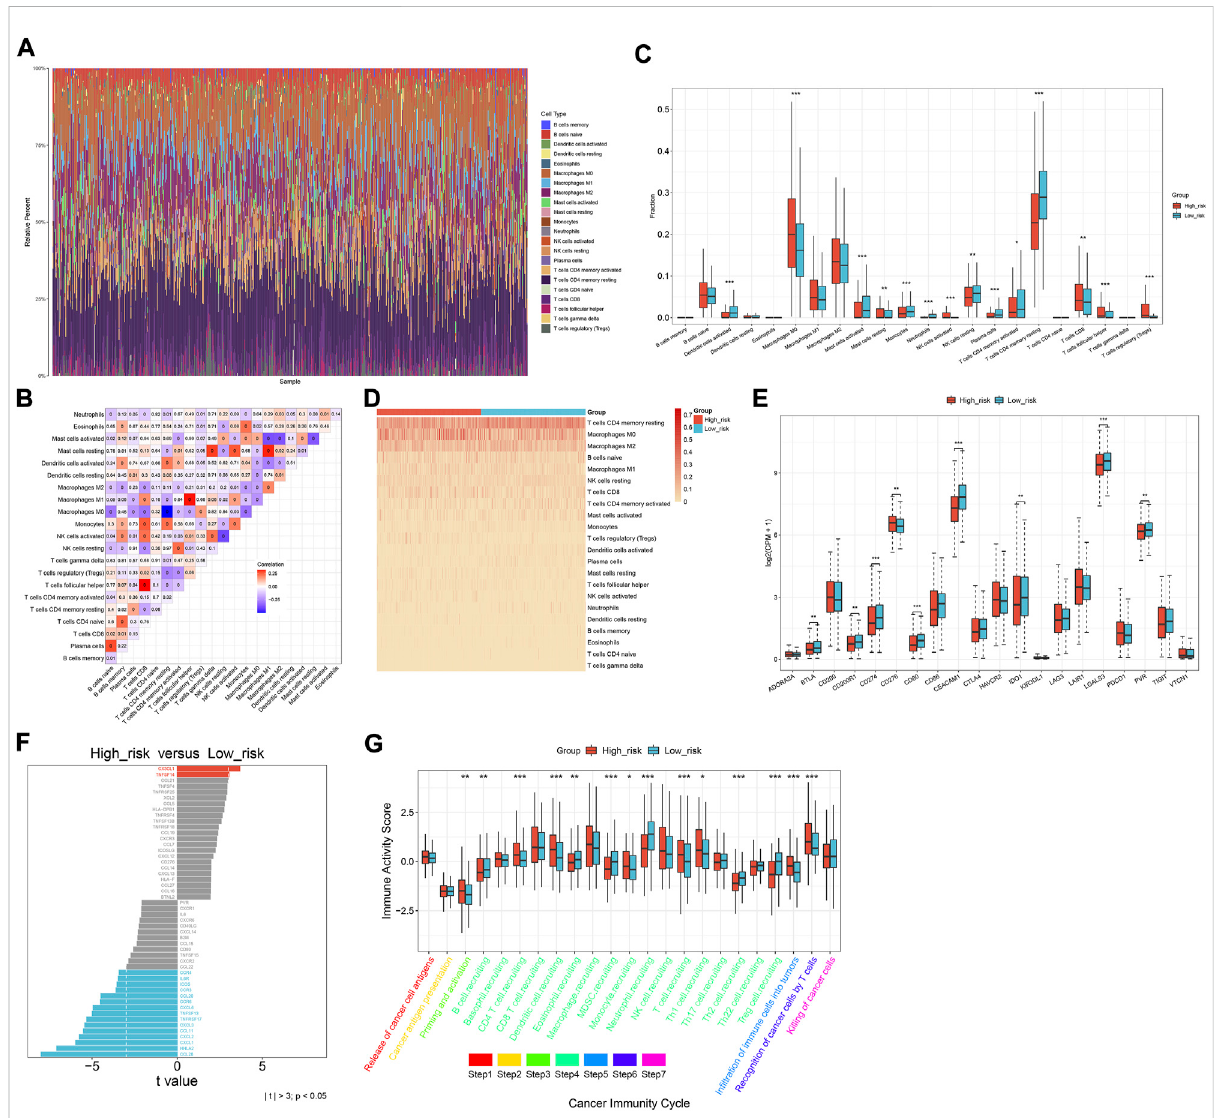
FIGURE 6 Oxidative stress-related gene signature correlates to the antitumor immunity of CRC. (A) Relative percent of the in fi ltration levels of immune cells across TCGA CRC. (B) Correlations between different immune cell populations. (C,D) Comparison of the in fi ltration of immune cells between subsets. (E) Comparison of immune checkpoints between subsets. (F) Difference in the expression of immunomodulators between subsets. (G) Difference in the activity of cancer immunity cycle between subsets. * p < 0.05; ** p < 0.01; *** p < 0.001. N =